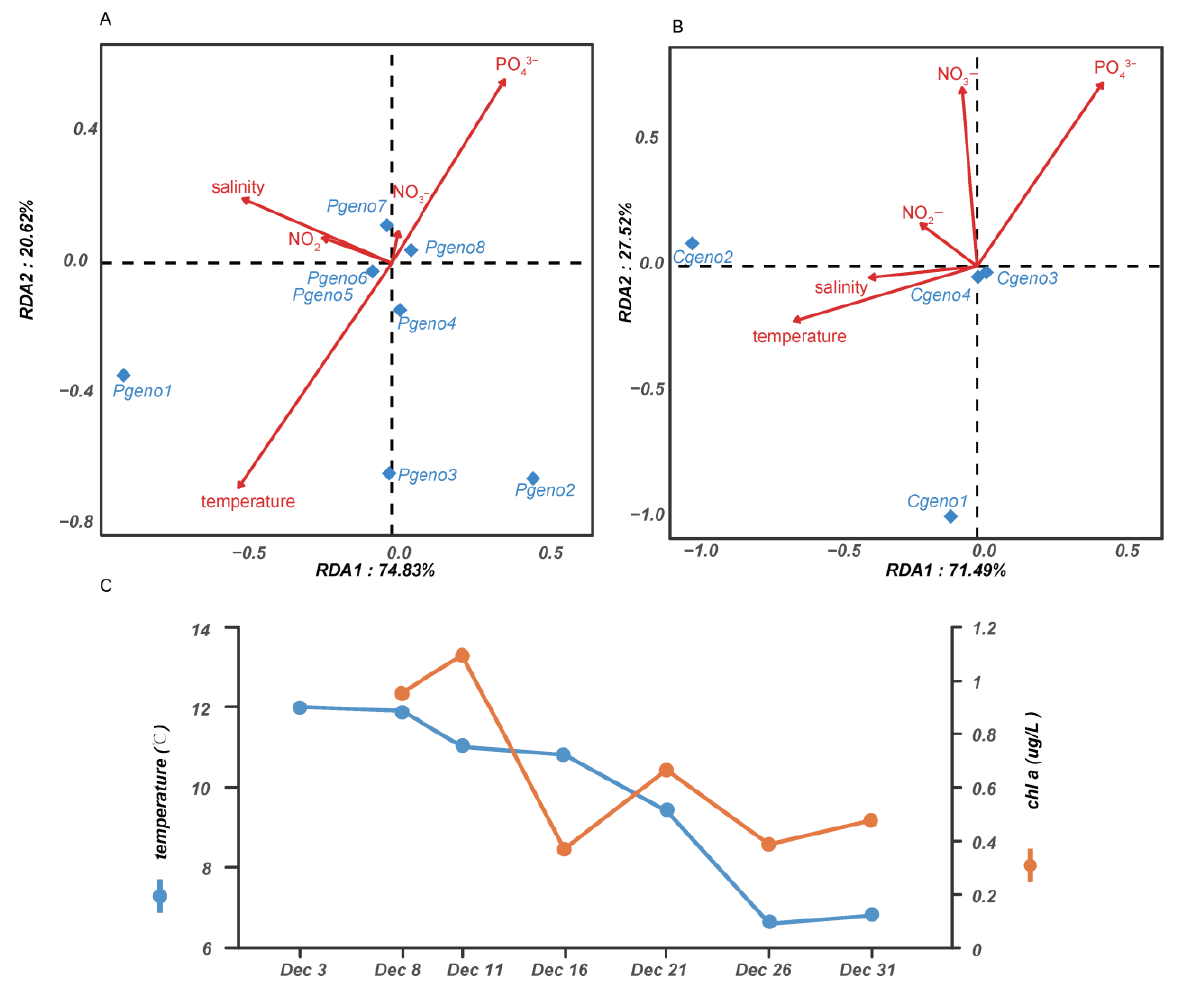
Figure 4. Redundancy analysis (RDA) of the environmental factors. ( A ) The pgcp1 genotypes. ( B ) The cox1 genotypes. Blue tetrapods indicate genotypes. ( C ) Measurements of temperature and Chl a concentration during the sampling period.